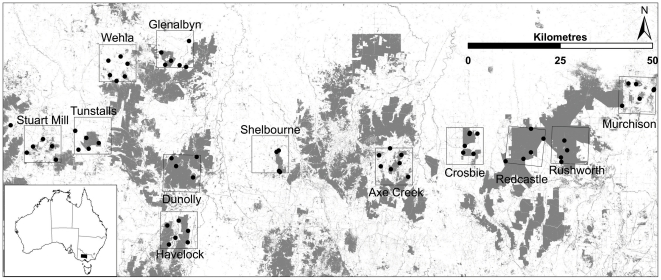
The study area in central Victoria, Australia, showing landscapes, sampling sites and remnant tree cover (shaded).Values for landscape treecover (%) are: 1. Landscapes with aggregated tree cover; Shelbourne 12%, Glenalbyn 17%,Tunstalls 20%, Crosbie 26% Havelock 45%. 2. Landscapes with dispersed tree cover; Welha 11%, Stuart Mill 19%, Murchison 27%, Axe Creek 35%, 3. Landscapes with continuous tree cover; Redcastle 75%, Dunolly 79%, Rushworth 79%.